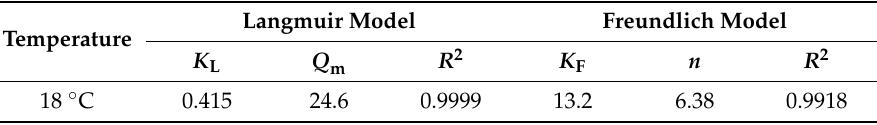
Figure 11. Langmuir and Freundlich isotherms of Li + adsorption by HMO at 18 °C. Table 5. Adsorption isotherm constants of Li + on HMO.